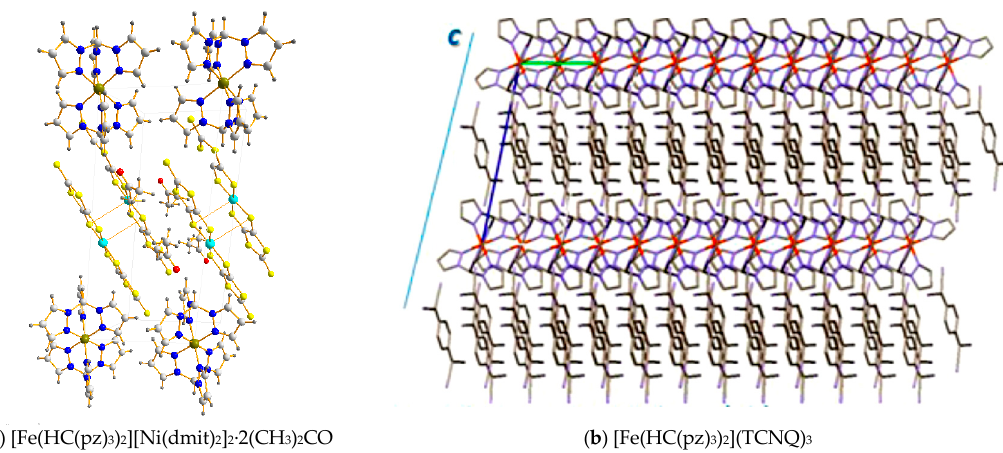
Figure 6. Fragment of the crystal packing with showing alternate cationic and anionic layers: ( a )—Coordination interactions Ni ⋯ S in the anionic dimers and interlayer C − H ⋯ S contacts (2.81–2.96 Å) between cations and anions; ( b )—Stacking interactions in the anionic columns and interlayer C − H ⋯ N contacts (2.41–2.70 Å) between cations and anions (conducting TCNQ plane ( a , b )). The mononuclear iron(II) complex [Fe(HC(pz) 3 ) 2 ](tcp) 2 containing the mono-negative